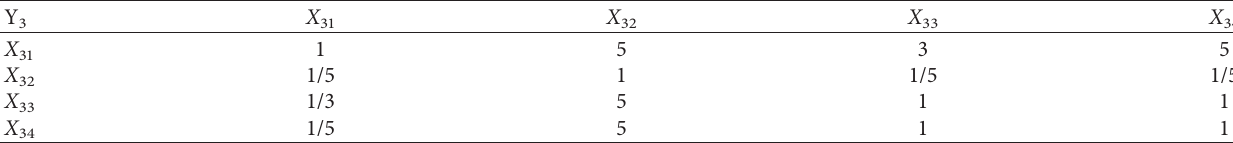
Table 7: Judgment matrix of the transport phase.